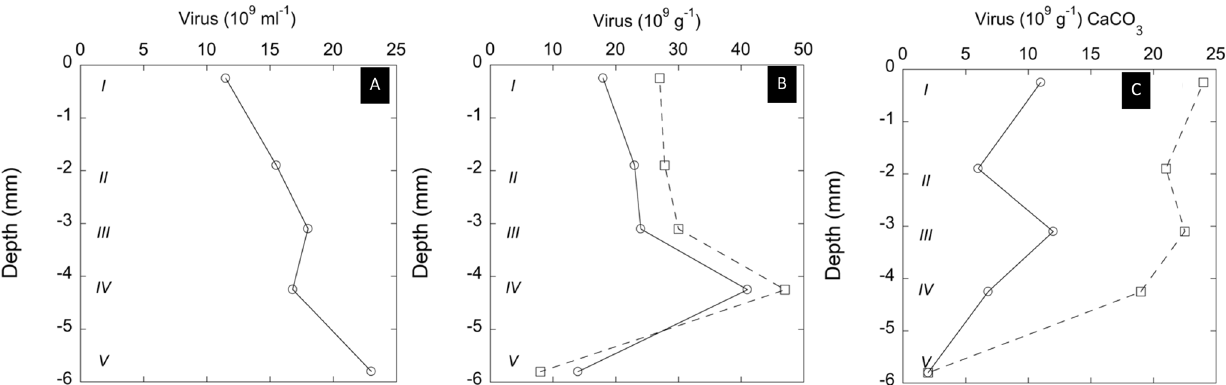
Fig 2. Virus observed in different depth layers (see below) and different fractions of the microbial mat dominated by diatoms, Coleofasciculus chthonoplastes , and Chloroflexus -like bacteria (CLB), sampled in September 2007. A: Virus counts in the extracted water fraction (pore water and water soaked into the extracellular polymer matrix). B: Virus attached to solid organic and mineral matter. (circles = without acidification, squares = after 10 min of acidification, see Methods). C: Virus associated with extracted and purified carbonate grains observed on the outside of the carbonate grains (circles) and after 10 min of acidification (squares). See Methods for details. Description of the different layers: I: the yellow brown toplayer (0 – 1 ± 0.1 mm depth) was dominated by the diatom species belonging to the genera Frustula , Cymbella , Denticula , Nitzschia ; II: layer B (1 ± 0.1 mm to 2.3 ± 0.2 mm depth) comprised bundles of C . chthonoplastes and filaments of CLB; III: layer (2.3 ± 0.2 mm to 3.9 ± 0.2 mm depth) corresponding to a transition zone with C . chthonoplastes and filaments of CLB, some of them showing signs of degradation; IV: deeply black coloured sediment (3.9 ± 0.3 mm to 5 ± 0.3 mm depth); V: layer (5 ± 0.3 mm to 6.4 ± 0.4 mm depth) was grey coloured with a lot of sand grains, other mineral particles. Biogenic high-Mg calcite grains were observed by microscopy in layers I, II, III, and